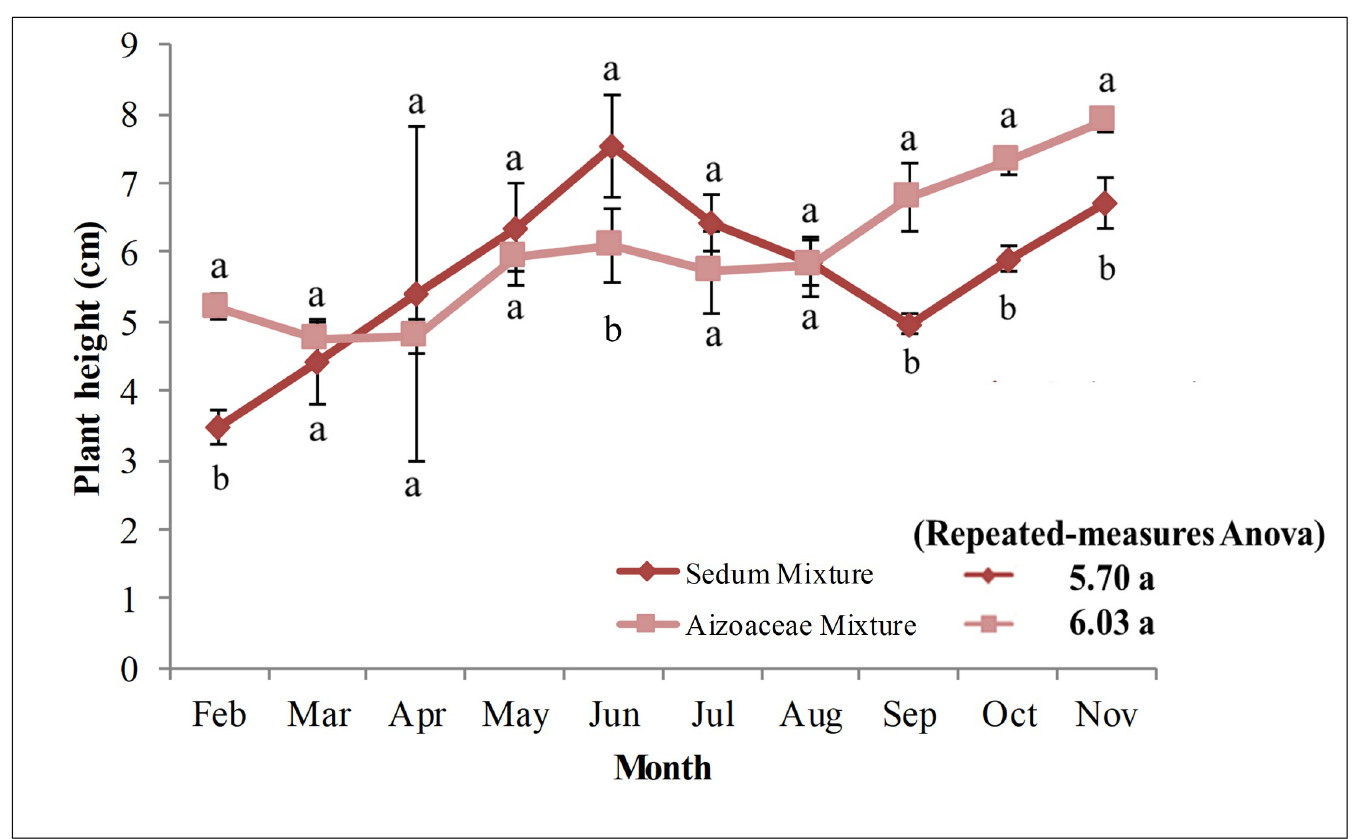
Fig 2. Plant heights for the two succulent mixtures (Feb-Nov 2011). Values are means ± SE. For each data, histograms with different letters are significantly different at p � 0.05.